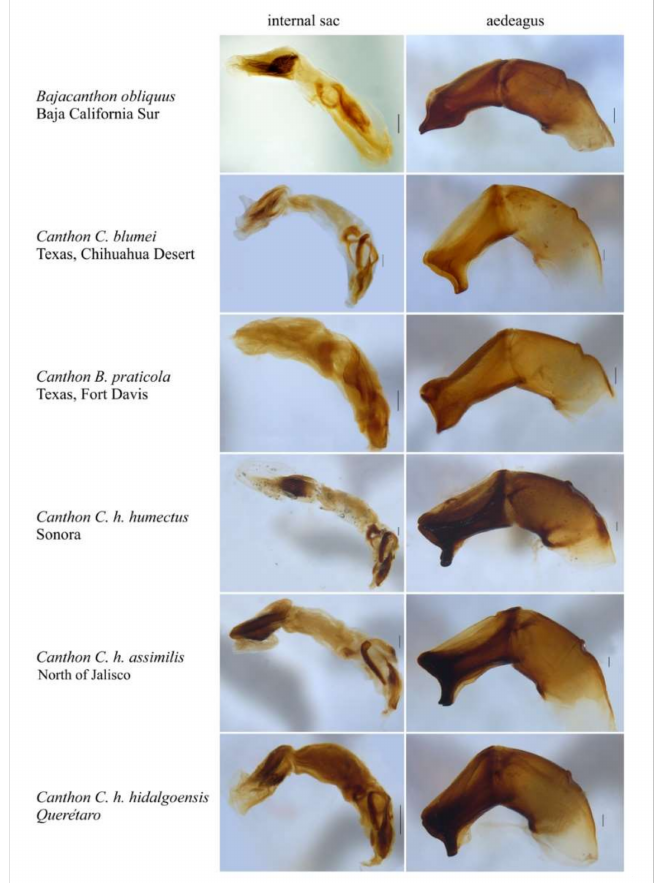
Figure 5. Comparison of the anatomy of the genital internal sac and aedeagus of Canthon ( Bajacanthon ) obliquus with related taxa of Deltochilini. Scale = 0.2